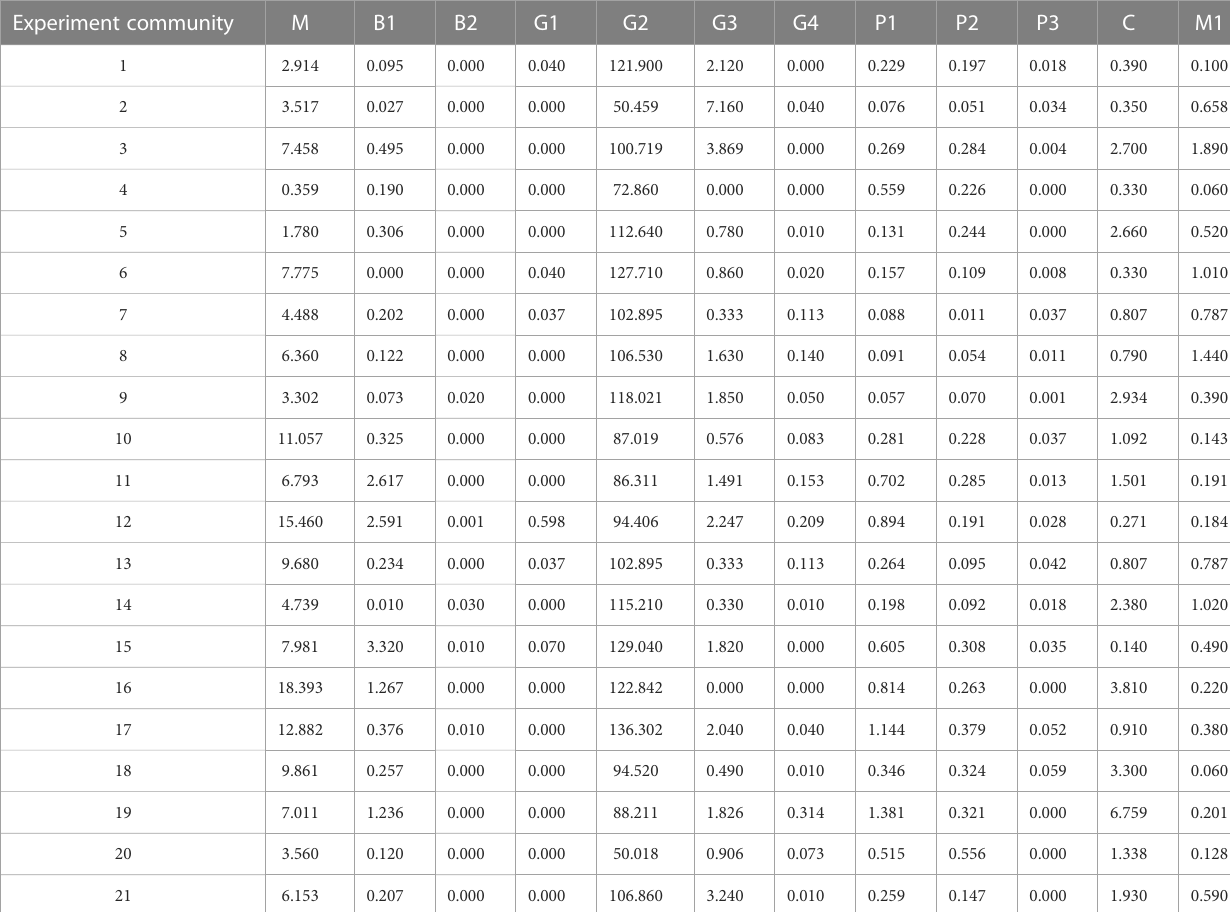
TABLE 4 Biomass of Manila clam and macrobenthos functional group (g/m 2 ). Experiment